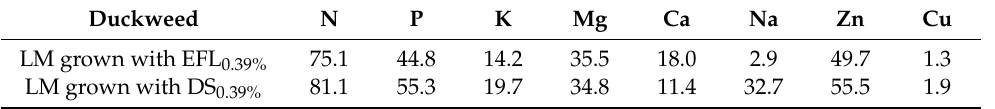
Table 8. An apparent nutrient recovery (ANR) from EFL 0.39% and DS 0.39%. Duckweed N P K Mg Ca Na Zn Cu LM grown with EFL 0.39% 75.1 LM grown with DS 0.39% 81.1 LM, Lemna